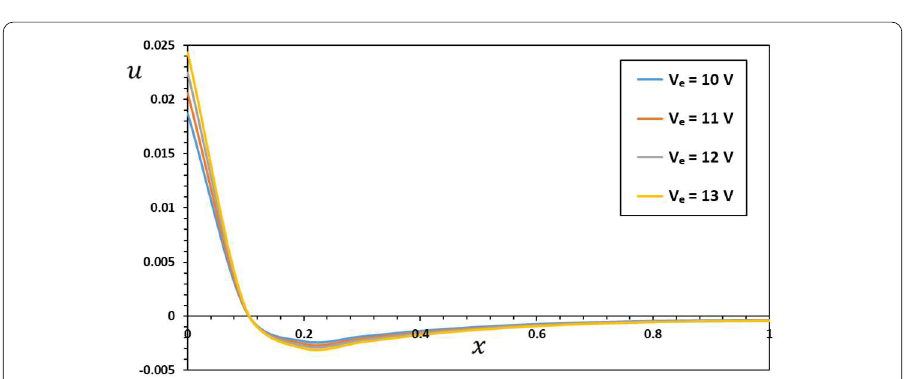
Figure 12 The effect of electric voltage V 2 e on the variation of the displacement u